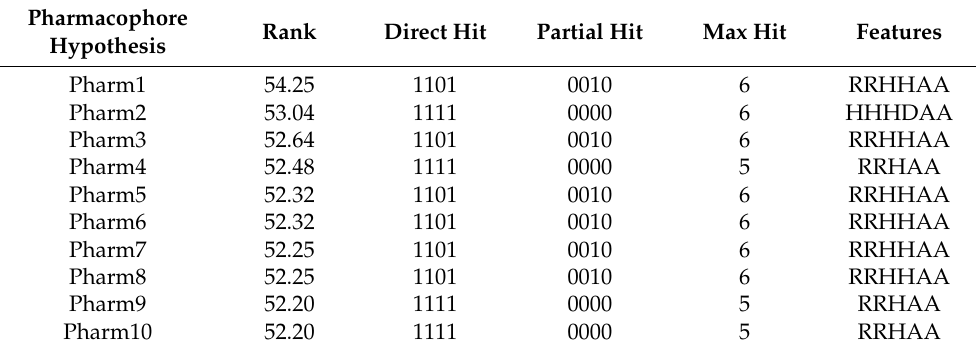
Table 3. The ten best common feature-derived hypothetical pharmacophores constructed on the basis of four clinically approved EGFR